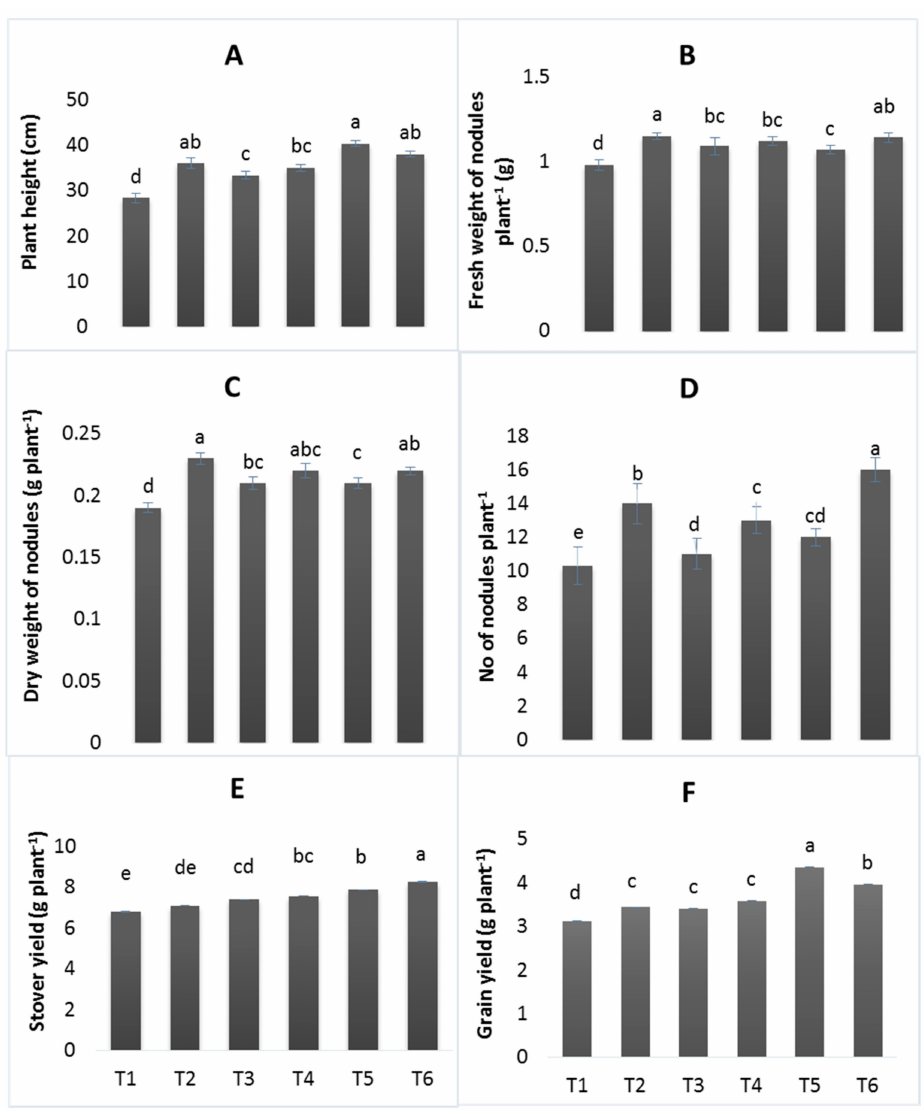
Figure 1. Effect of plant growth hormone and Rhizobium sp. On growth ( A , B ), nodulation ( C , D ) and yield ( E , F ) attributes of chickpea. T1: untreated control, T2: Rhizobium sp. Inoculation, T3: GA3 (10 − 4 M), T4: GA3 (10 − 5 M), T5: Rhizobium + GA3 (10 − 4 M), T6: Rhizobium +GA3 (10 − 5 M). Quantities sharing similar letters are not statistically different from each other at p >